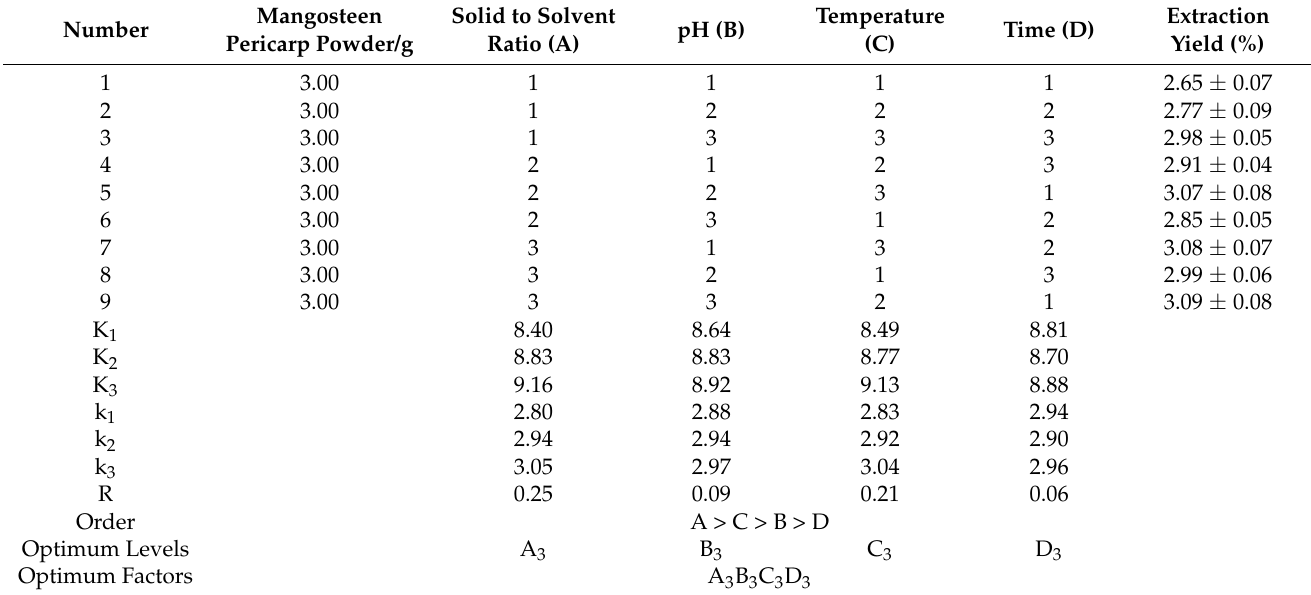
Table 1. Orthogonal test results of extraction yield of